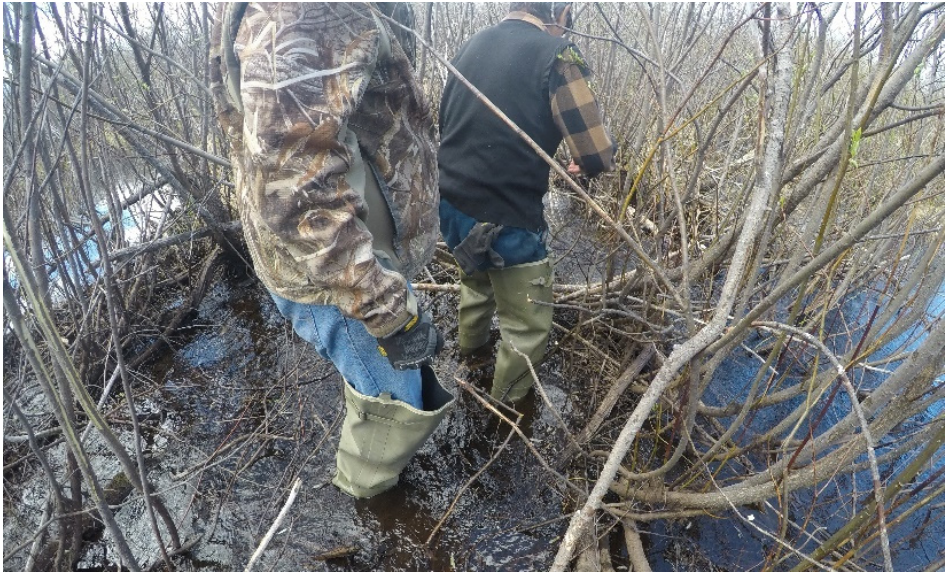
Figure 8. An Elder and On-the-land expert participant using hip waders to access a dam.